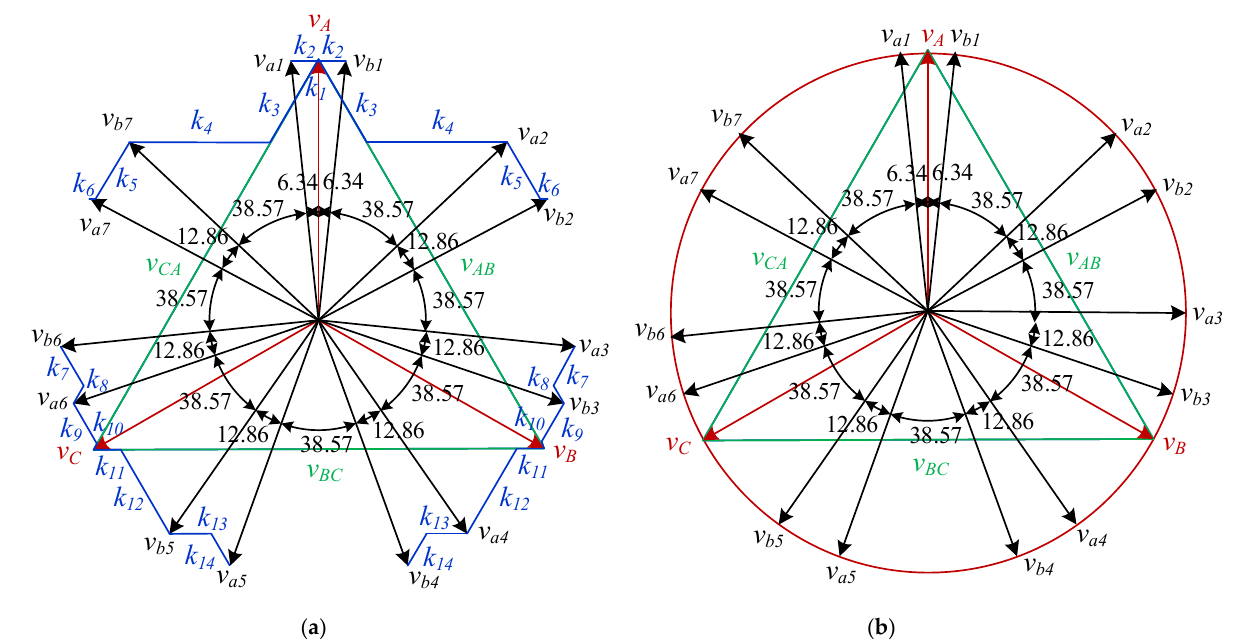
Figure 3. Representations of the ( a ) phasor and ( b ) connections of the PCA for the 28-PR.